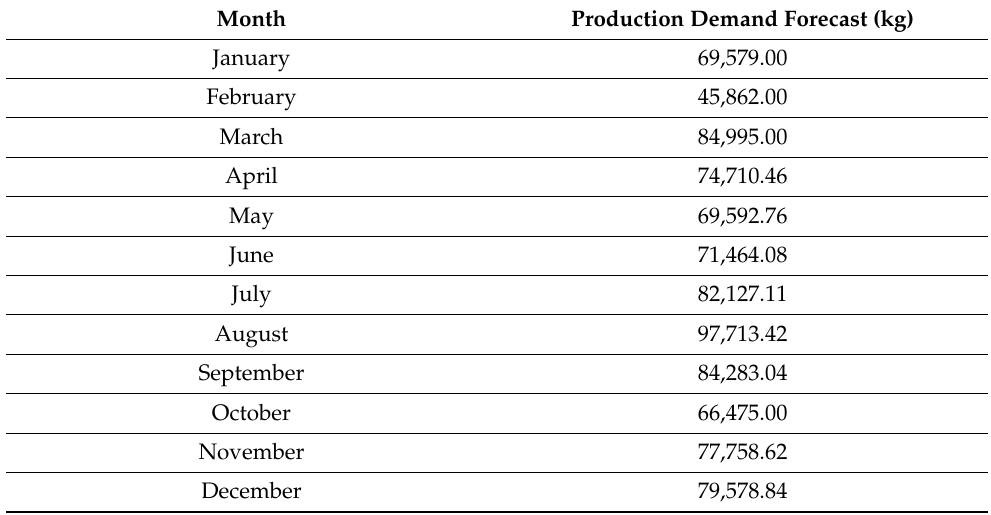
Table 2. Production demand